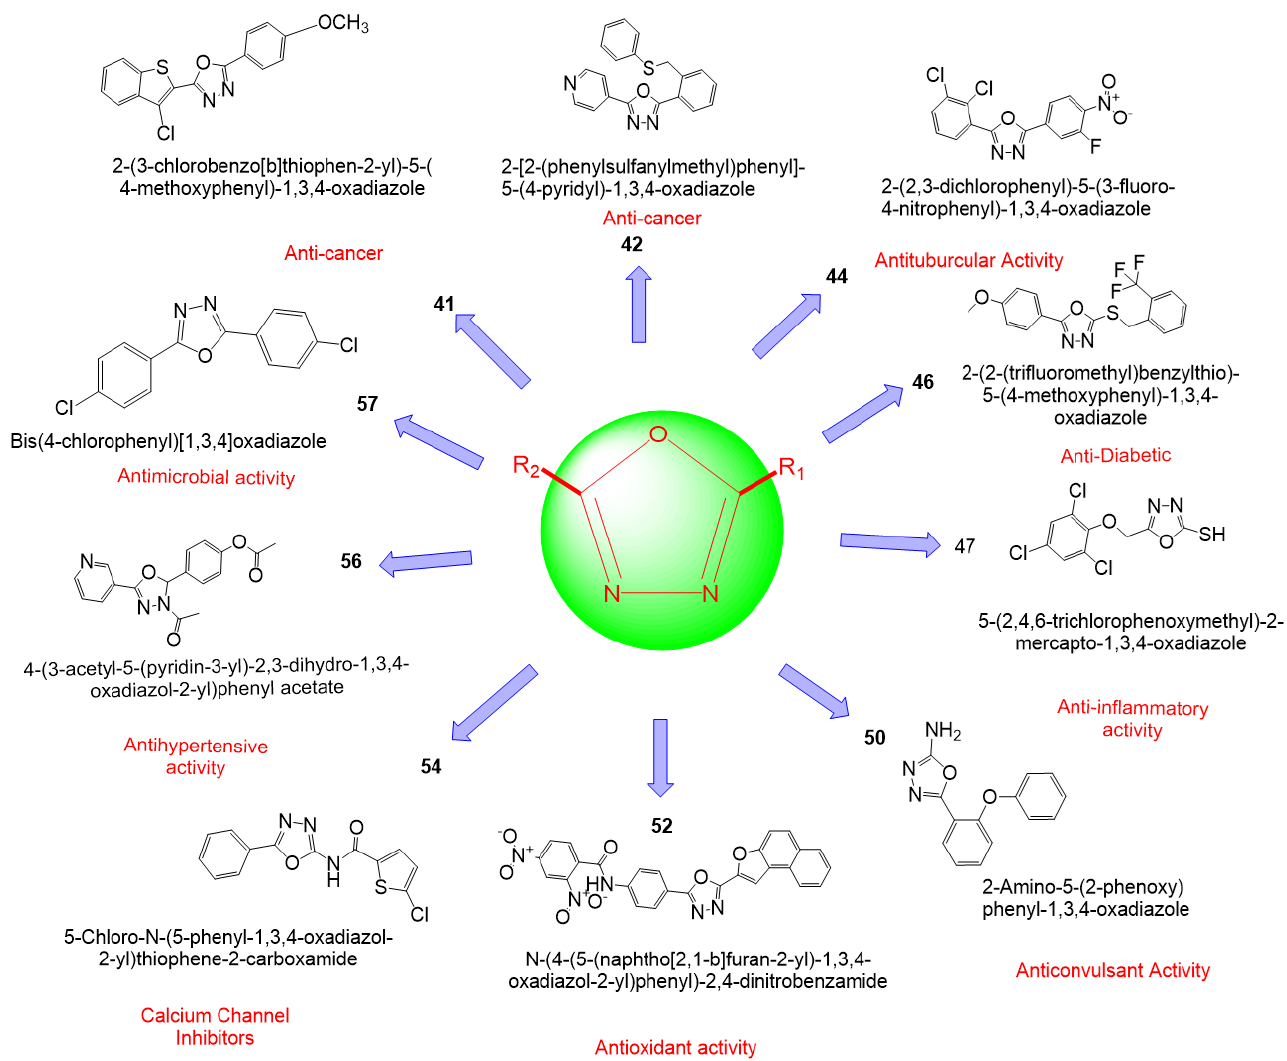
Figure 7. The biological activity of 1,3,4-oxadiazole derivatives .